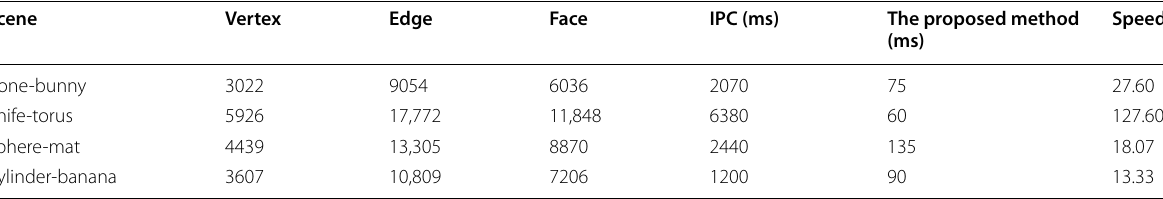
Table 1 Execution time of the proposed method and IPC